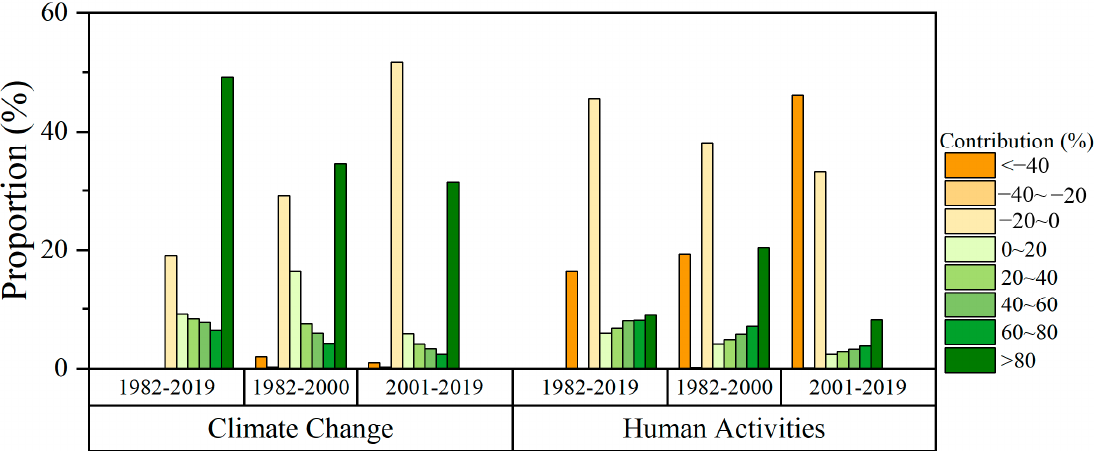
Figure 10. Area proportion of driving factors for vegetation changes on the QTP in different time periods.